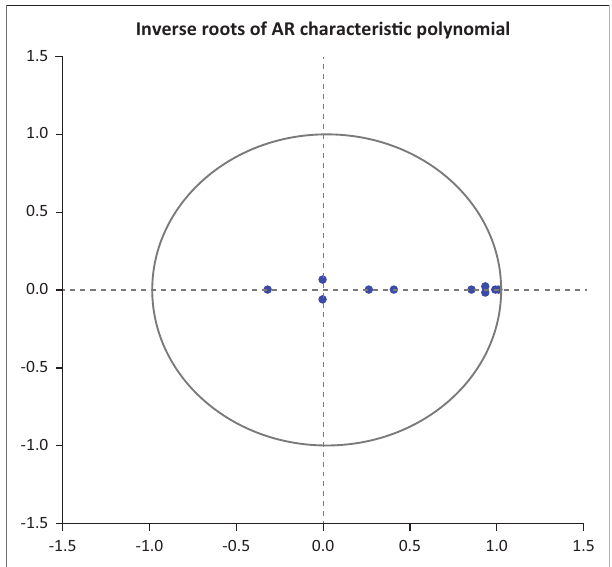
FIGURE 1: Stability reliability